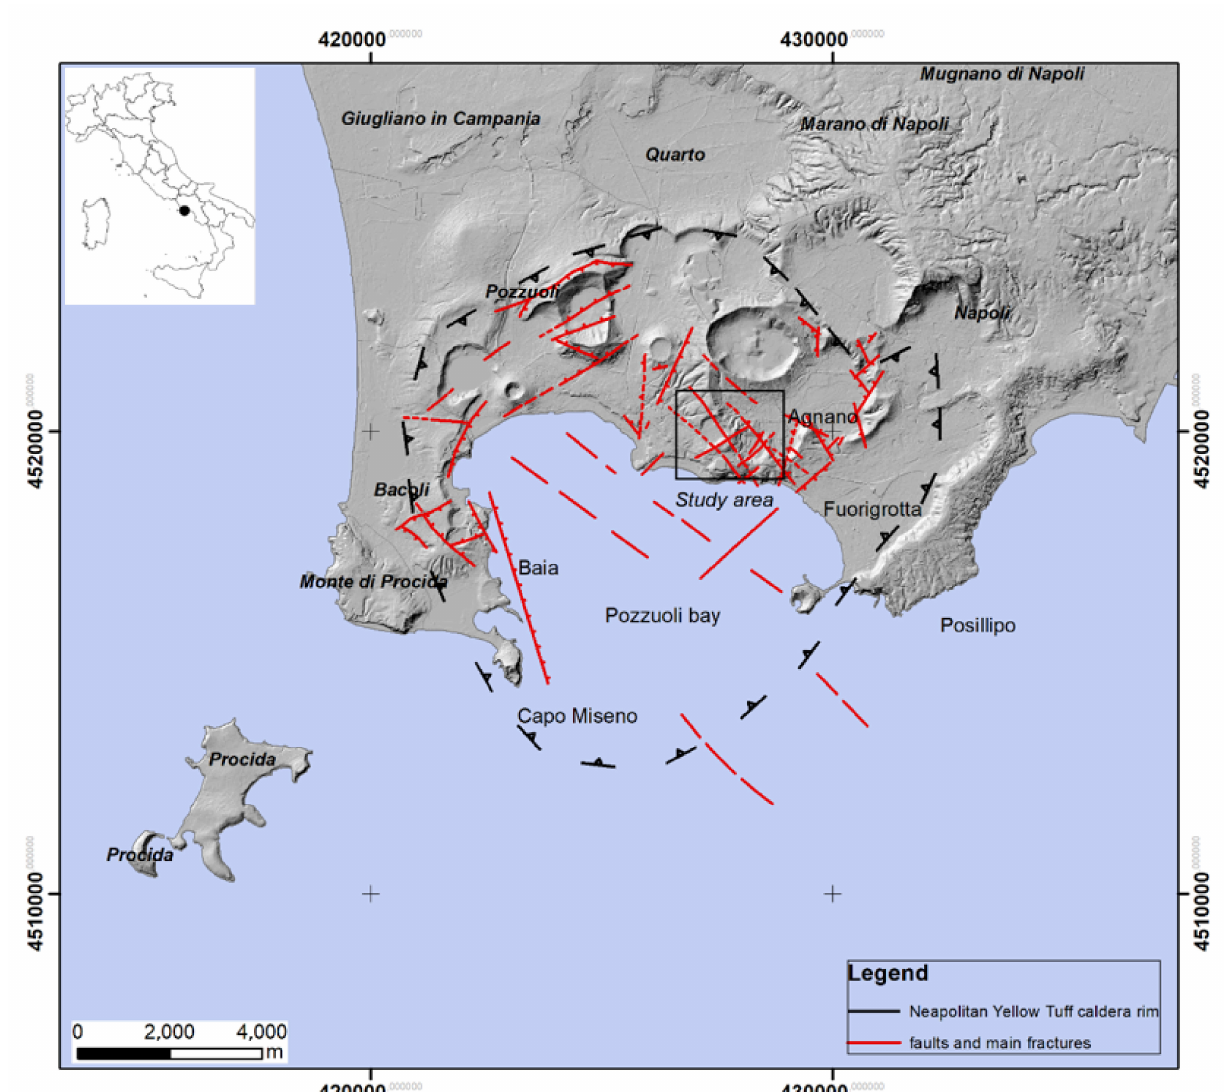
Figure 1. Campi Flegrei caldera showing the main volcano-tectonic structures. The used coordinate system is WGS84/UTM zone